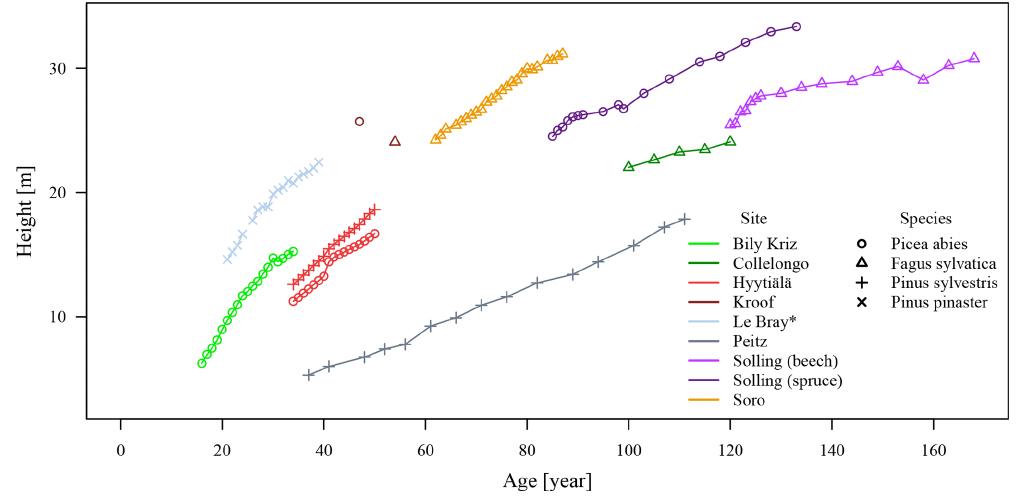
Figure 7. Time series of tree height versus age of the forest stands in the PROFOUND DB. The basal area-weighted mean height is shown for all stands with the exception of Le Bray for which the arithmetic mean height is shown (marked by ∗ ). For Sorø, the heights have been reconstructed (see text in Sects. 4.9 and S1). Table 5. Summary of the observed carbon fluxes at the sites in the PROFOUND DB. Shown is the range (min and max) and the average (in brackets) of the annual sums in the observational period. All data are estimates based on the CUTRef method with daytime data included for RECO and GPP. GPP is expressed with negative values because it is considered a downward flux from the atmosphere. Likewise, negative NEE values indicate a carbon sink and positive values a carbon